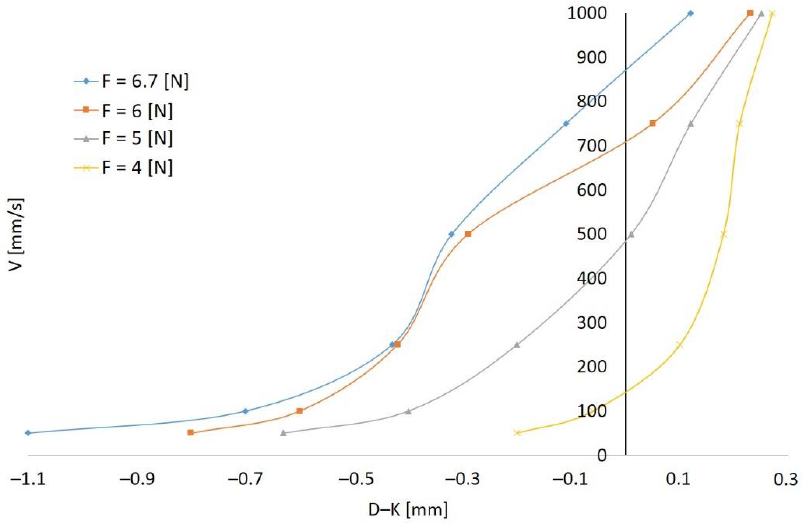
Figure 12. Graph of correctness of machining as a function of speed for different values of contact forces.